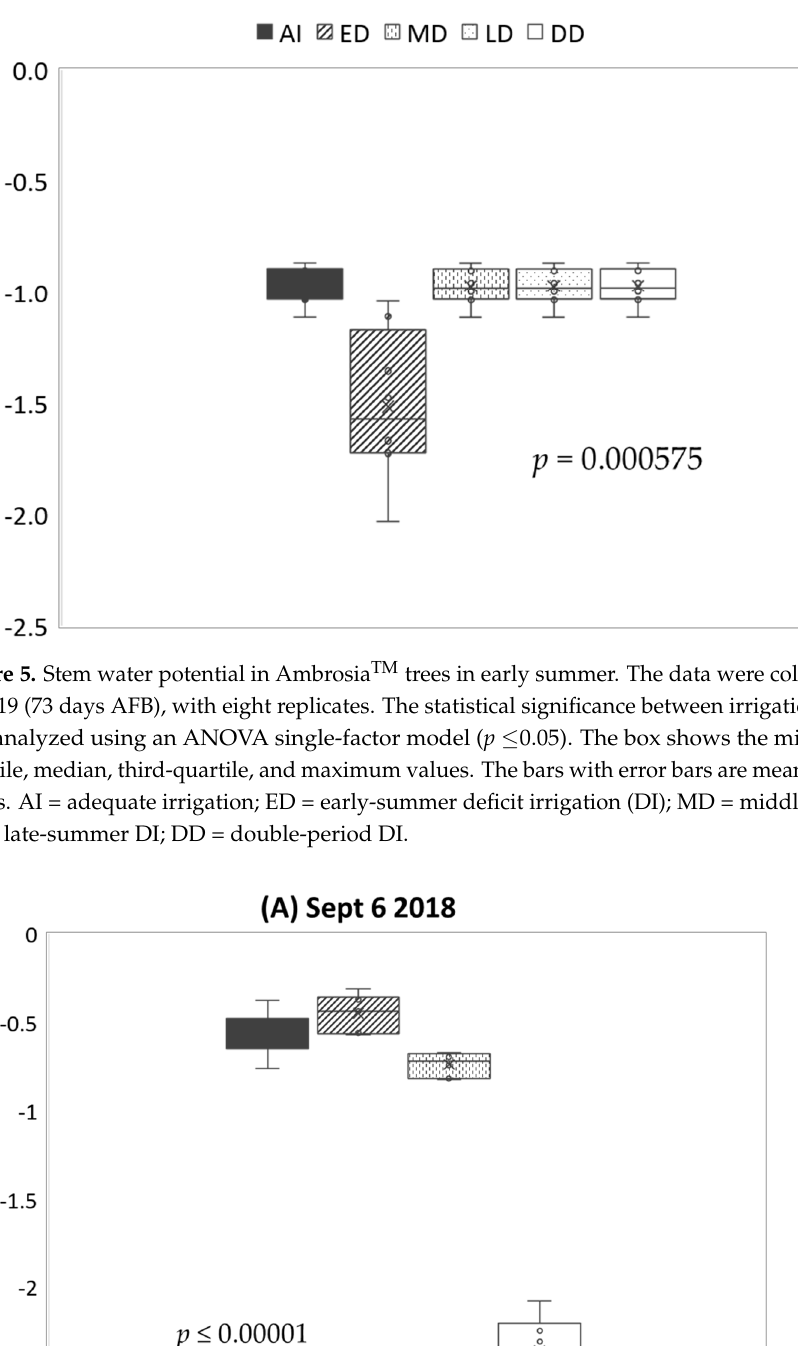
Figure 6. Stem water potential in Ambrosia TM trees in late summer. The data were collected on 6 September (125 days AFB) 2018 ( A ) and on 9 September (128 days AFB) 2019 ( B ), with eight repli ‐ cates, respectively. The statistical significance between irrigation treatments was analyzed using an ANOVA single ‐ factor model ( p ≤ 0.05). The box shows the minimum, first ‐ quartile, median, third ‐ quartile, and maximum values. The bars with error bars are means ± standard errors. AI = adequate irrigation; ED = early ‐ summer deficit irrigation (DI); MD = middle ‐ summer DI; DD = double ‐ period DI. 4. Discussion and Suggestions Irrigation is a substantial factor governing tree growth, fruit development and fruit quality [23]. Excessive irrigation causes vigorous growth [16] and the development of dis ‐ eases in fruit, such as bitter pits [39]; in contrast, water deficit led to the irregular growth of fruit (Tables 2 and 3) or even to the death of the tree (6 out of 18 trees died in DD in 2018, as indicated in Table S2). Because the climate in the Okanagan area was wet in the spring from the winter snow, with major rainfall for the whole growth season in the early summer (Figure 1), an early reduction in irrigation did not cause adverse affects in the